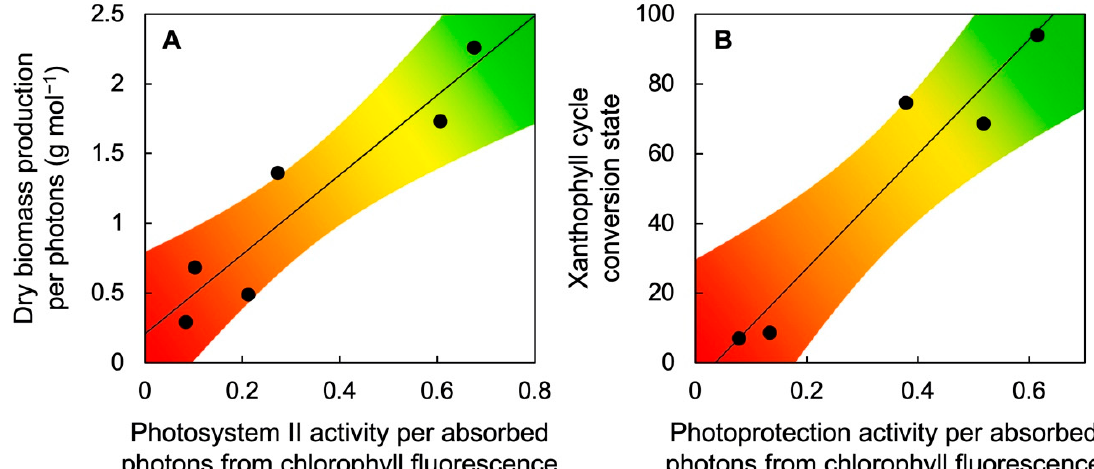
Figure 5. Relationship between ( A ) dry biomass production per photons and photosystem II activity per absorbed photons from chlorophyll fluorescence (as photosystem II efficiency from F v (cid:48) /F m (cid:48) × q P ; see [18,24]) or ( B ) xanthophyll cycle conversion state, (Z + A)/(V + A + Z), and the activity of non- photochemical dissipation of excess absorbed light from chlorophyll fluorescence (as photoprotective thermal dissipation from 0.8 − F v (cid:48) /F m (cid:48) ; see [18,24]) under six different growth-light conditions over a range of light intensities from 50 to 1000 µ mol photons m − 2 s − 1 . Data from [23,24]. A, antheraxanthin, V, violaxanthin, Z, zeaxanthin.